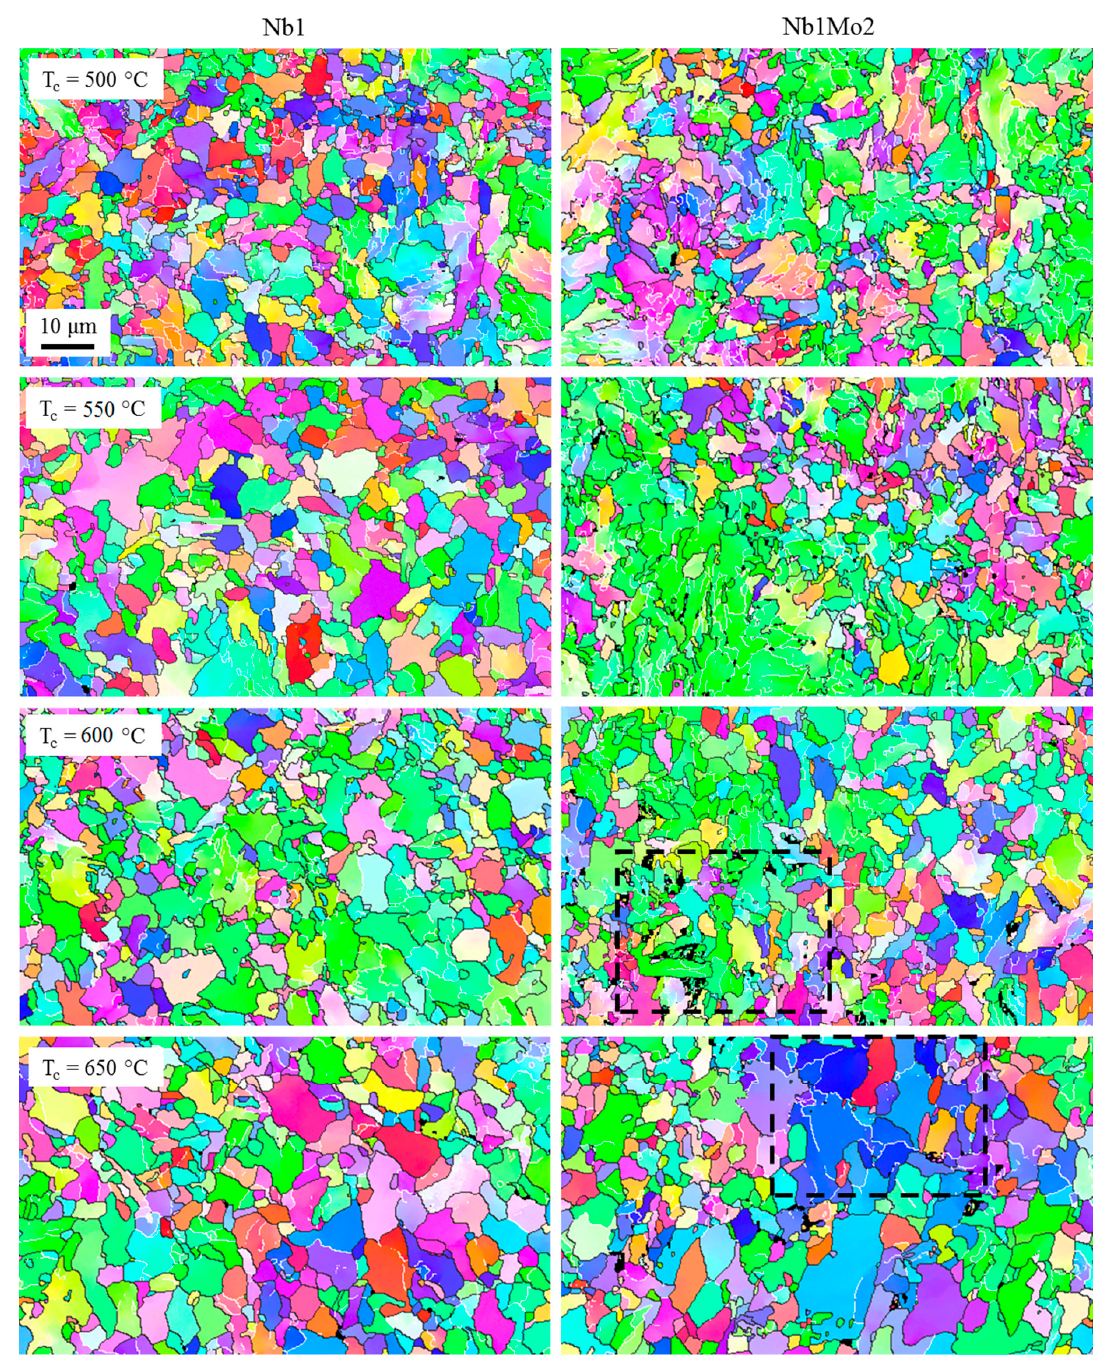
Figure 15. EBSD IPF maps for Nb1 steel ( left ) and Nb1Mo2 steel ( right ) after coiling simulation at four coiling temperatures, i.e., 500 °C, 550 °C, 600 °C and 650 °C, with a cooling rate of 0.5 °C/min for 3 h (HAGB in dark grey and LAGB in white, M/A in black). The areas indicated by dashed lines are shown in more detail in Figure 16.